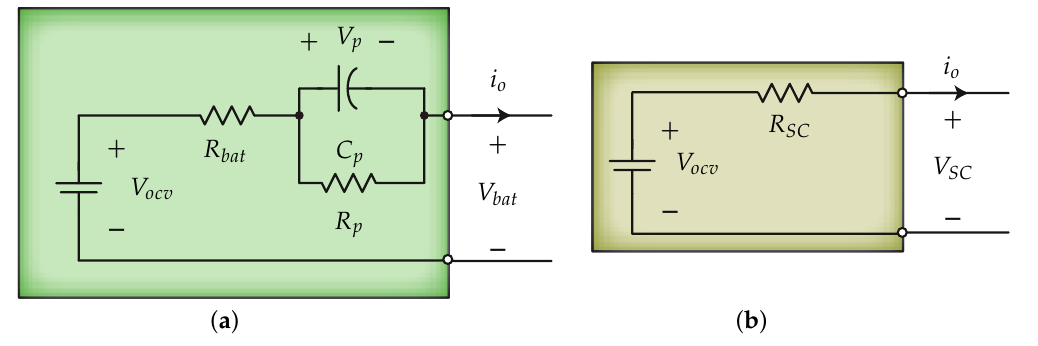
Figure 4. Circuit diagram of ( a ) the battery model and ( b ) the SC model.